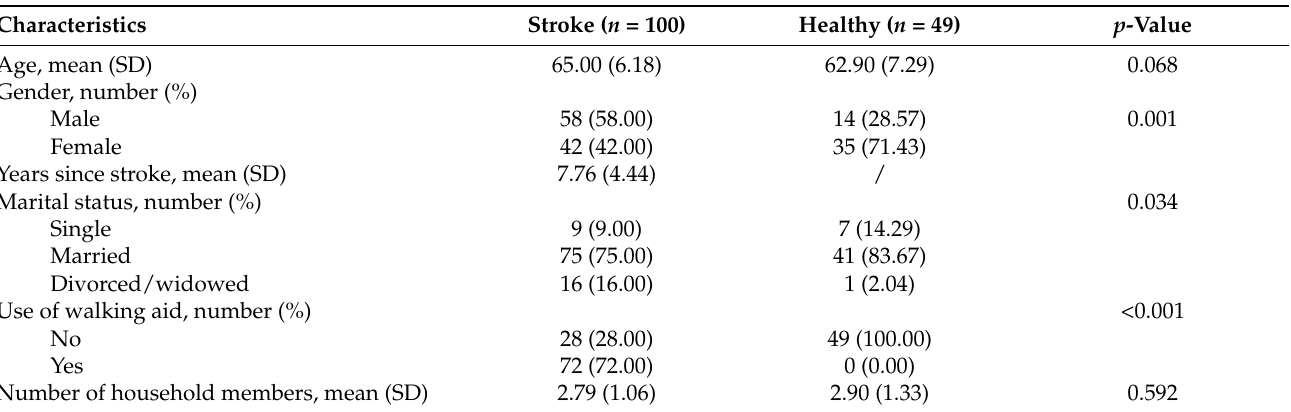
Table 1. Demographic characteristics of the